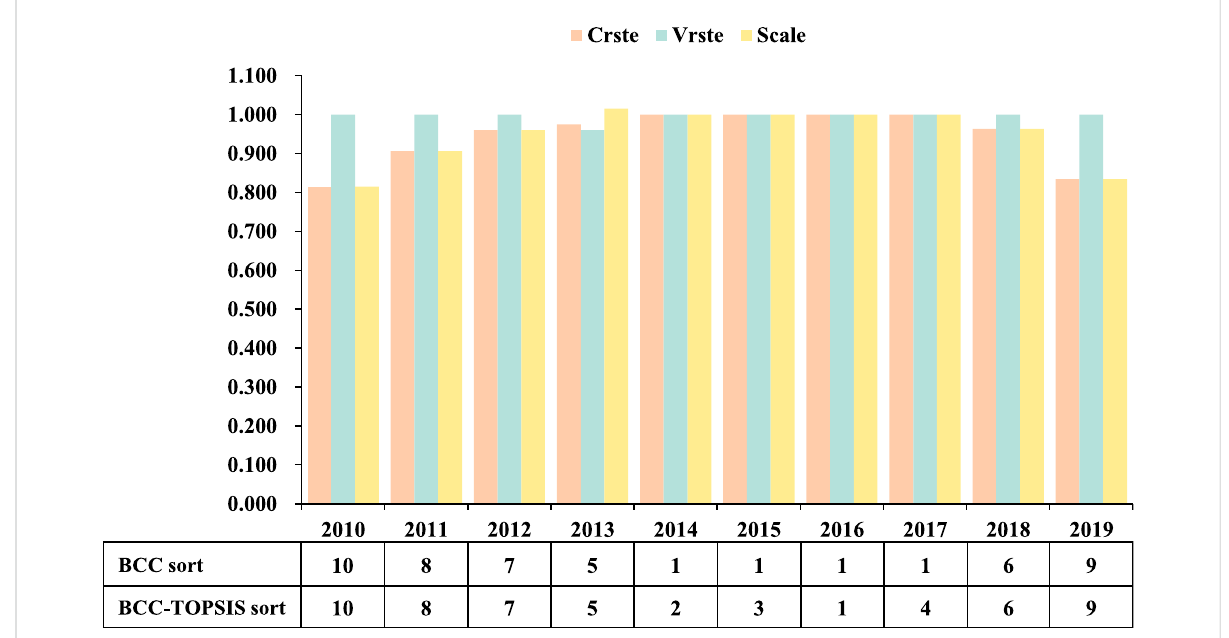
FIGURE 6 Evaluation results of the ef fi ciency of National Grid ’ s investment and merger in the fi eld of energy Internet.